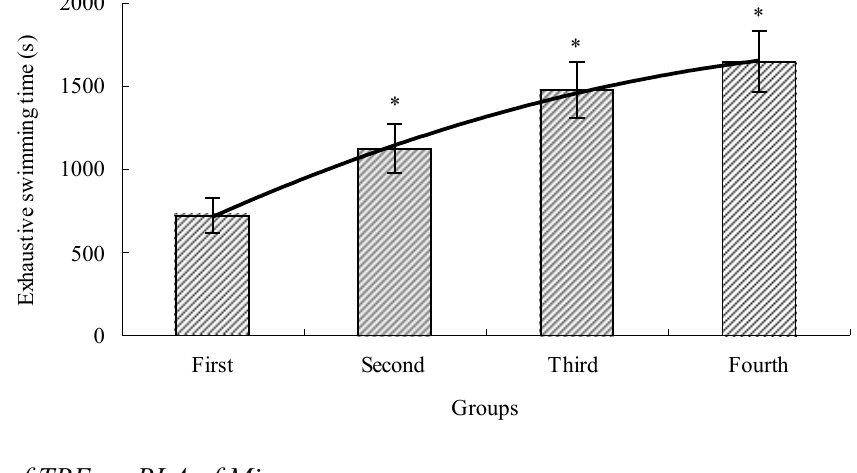
Figure 1. The effects of tartary buckwheat extracts (TBE) on exhaustive swimming time of mice. Values are means ± SD. * P < 0.05 when compared to the control group (first group).